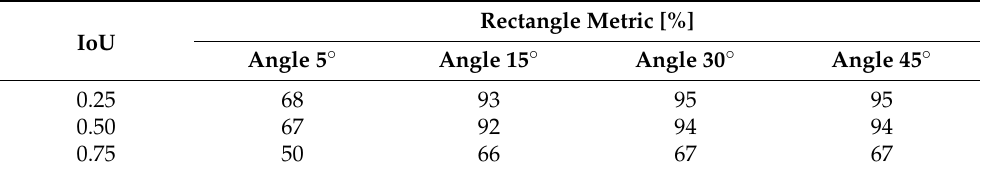
Table 3. Evaluation results of grasp detection on the test